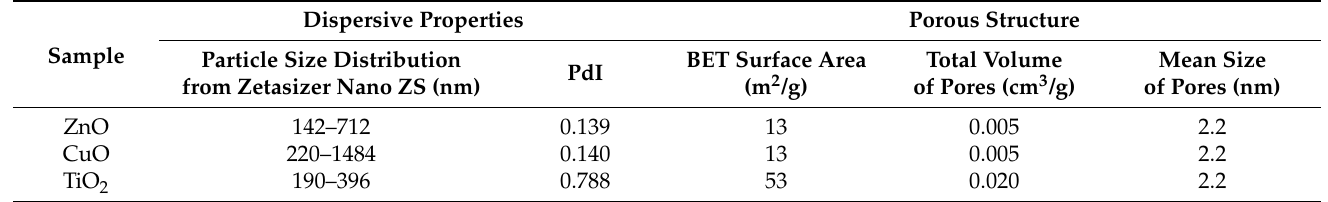
Table 2. Tabulated data of dispersive properties and porous structure properties of pristine